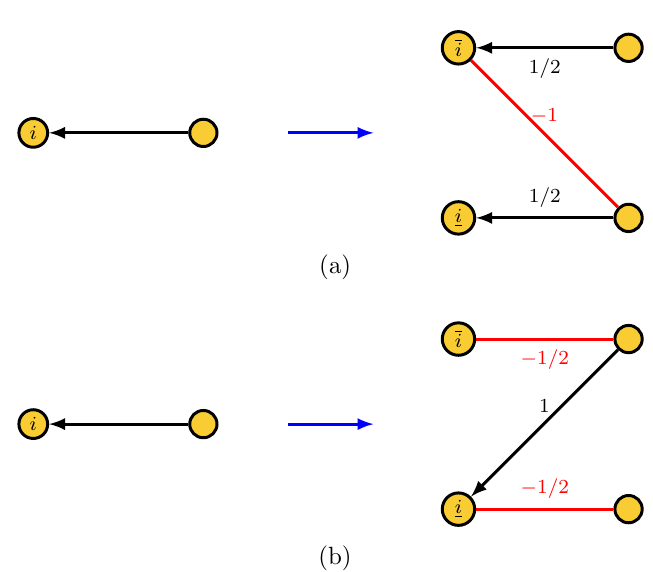
Figure 6. 2 d descendants of an incoming 4 d chiral (cid:12)eld at node i that: a) is not in p and b) is